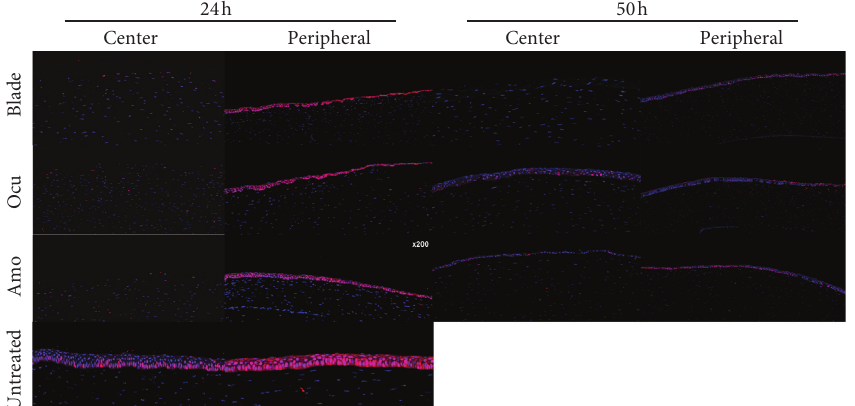
Figure 2: Proliferating cell nuclear antigen (PCNA) staining at 24 and 50 hours after epithelial removal in the three groups and an untreated control.